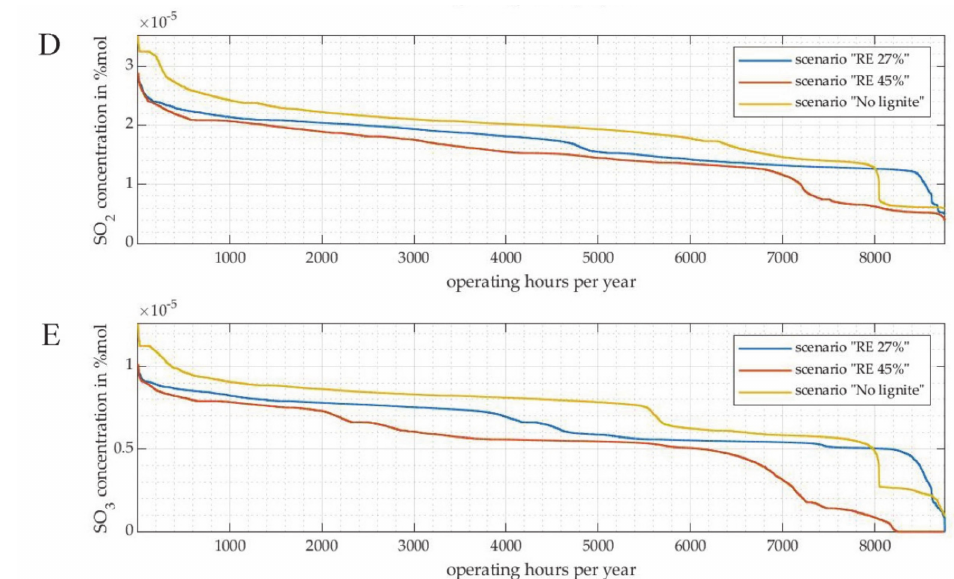
Figure 10. Modelled occurrence of di ff erent impurity concentrations at the trunk line entry per year—a comparison between the energy mix scenarios. (Occurrences of H 2 , CO, O 2 , SO 2 , and SO 3 concentrations are given in ( A – E ),